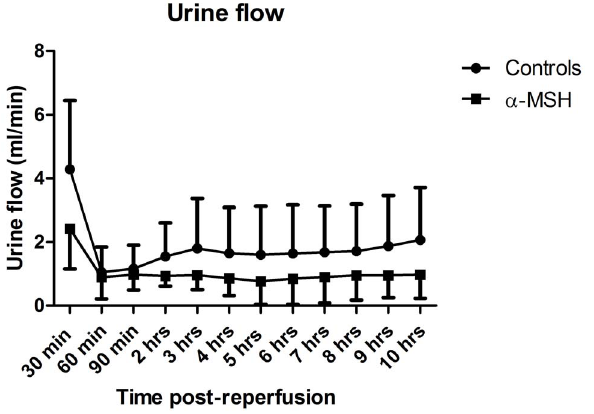
Figure 2. Effect of a -MSH on urine flow. Urine flow was significantly lower in the a -MSH group compared to controls during ten hours follow-up. doi:10.1371/journal.pone.0094609.g002 PLOS ONE |